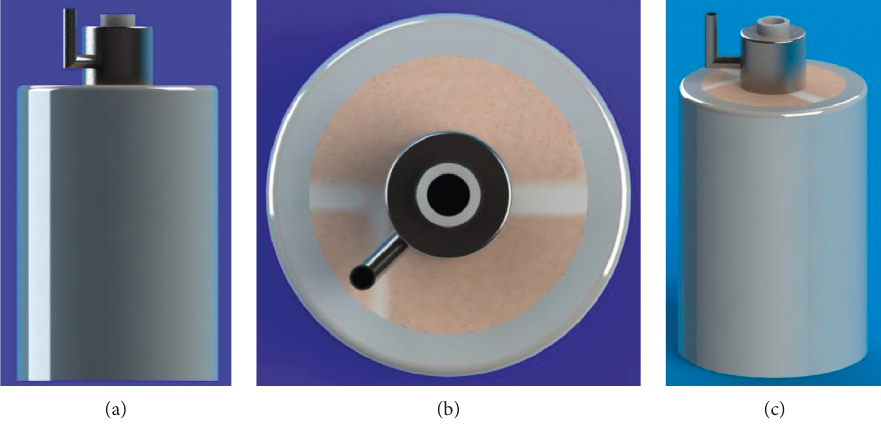
Figure 16: Outside view of the thermal pile: (a) front view; (b) plan view; (c) spatial